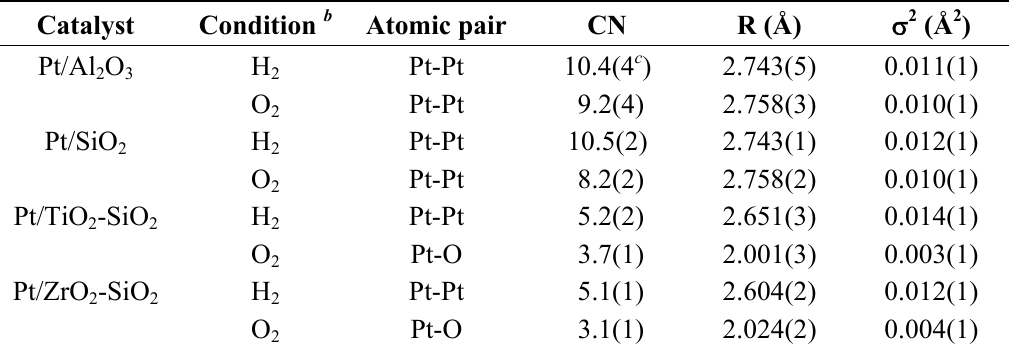
Table 2. EXAFS results a